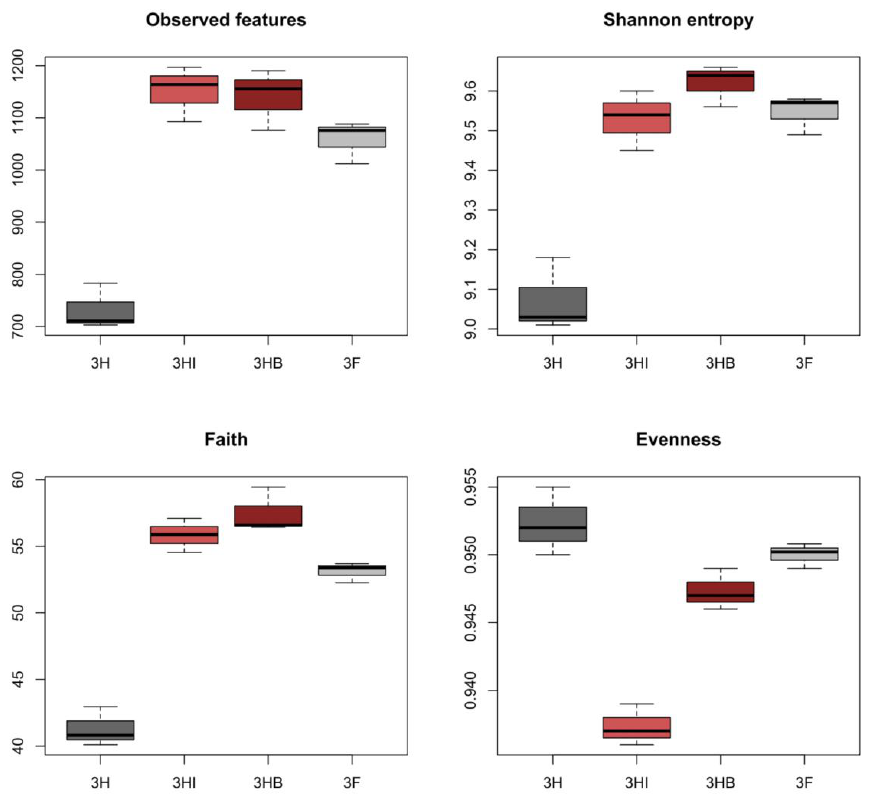
Figure 5. Alpha diversity indices of the soil microbial community between four different treatments. Data (mean ± standard deviation, n = 3). Half-dose PK-fertilizer, 3H; half-dose PK-fertilizer and free-cell strain 40a, 3HI; half-dose PK-fertilizer and encapsulated strain 40a, 3HB; full-dose PK-fertilizer, 3F.